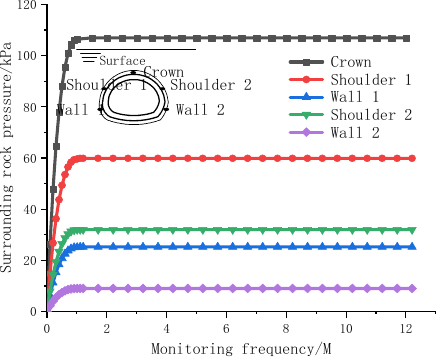
Figure 15. Monitoring values for confining pressures in shallowly buried tunnel. Table 2. Mechanical properties of T300 carbon fibre.